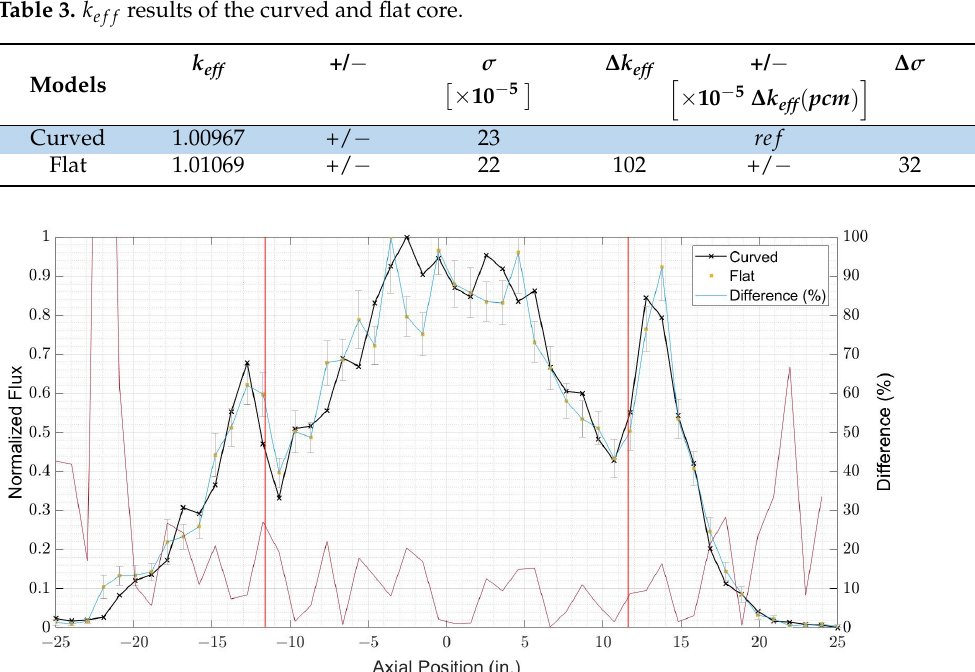
Figure 10. MSTR fl ux pro fi le produced by the MCNP5 and OpenMC models. MCNP5 fl ux data were obtained from reference [12], where the di ff erence (%) line indicates the error percentage between MCNP5 and OpenMC, while the vertical red line indicates the active fuel region.